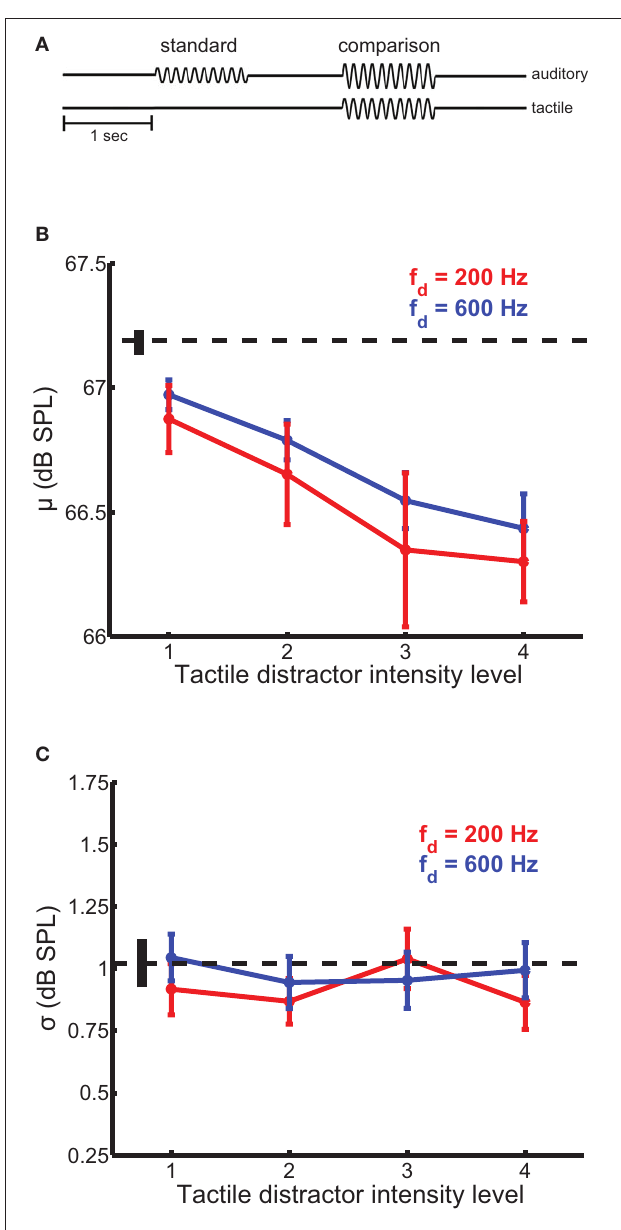
Figure 2 | Auditory intensity discrimination in the presence of tactile distractors. Conventions as in Figure 1 . (A) Experimental design. (B) Mean bias estimates (PSE) averaged across participants in the intensity discrimination experiments, as a function of distractor intensity. Bias estimates scaled with distractor intensity. The 200-Hz (red trace) and 600-Hz (blue trace) distractors biased intensity judgments of 200-Hz auditory tones comparably. (C) Mean sensitivity estimates averaged across participants in the intensity discrimination experiments. Tactile distractors did not significantly affect sensitivity